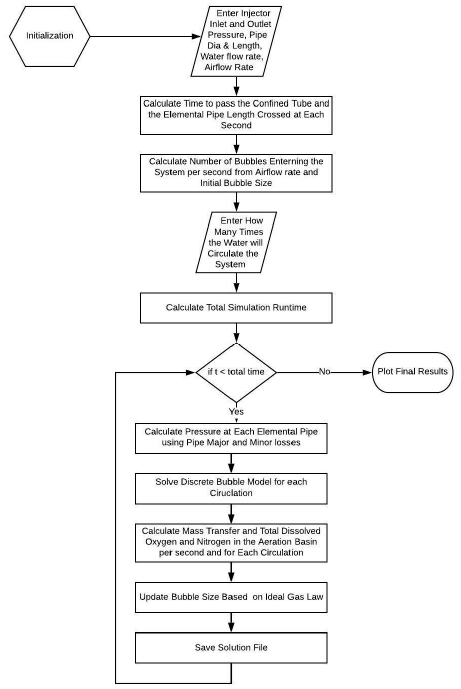
Figure 4. Representation of the Discrete Bubble Model algorithm.